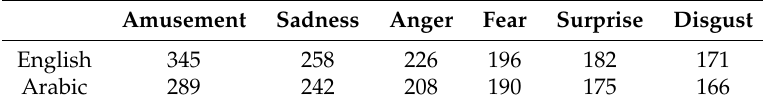
Table 4. Number of responses for each clip in the online survey.